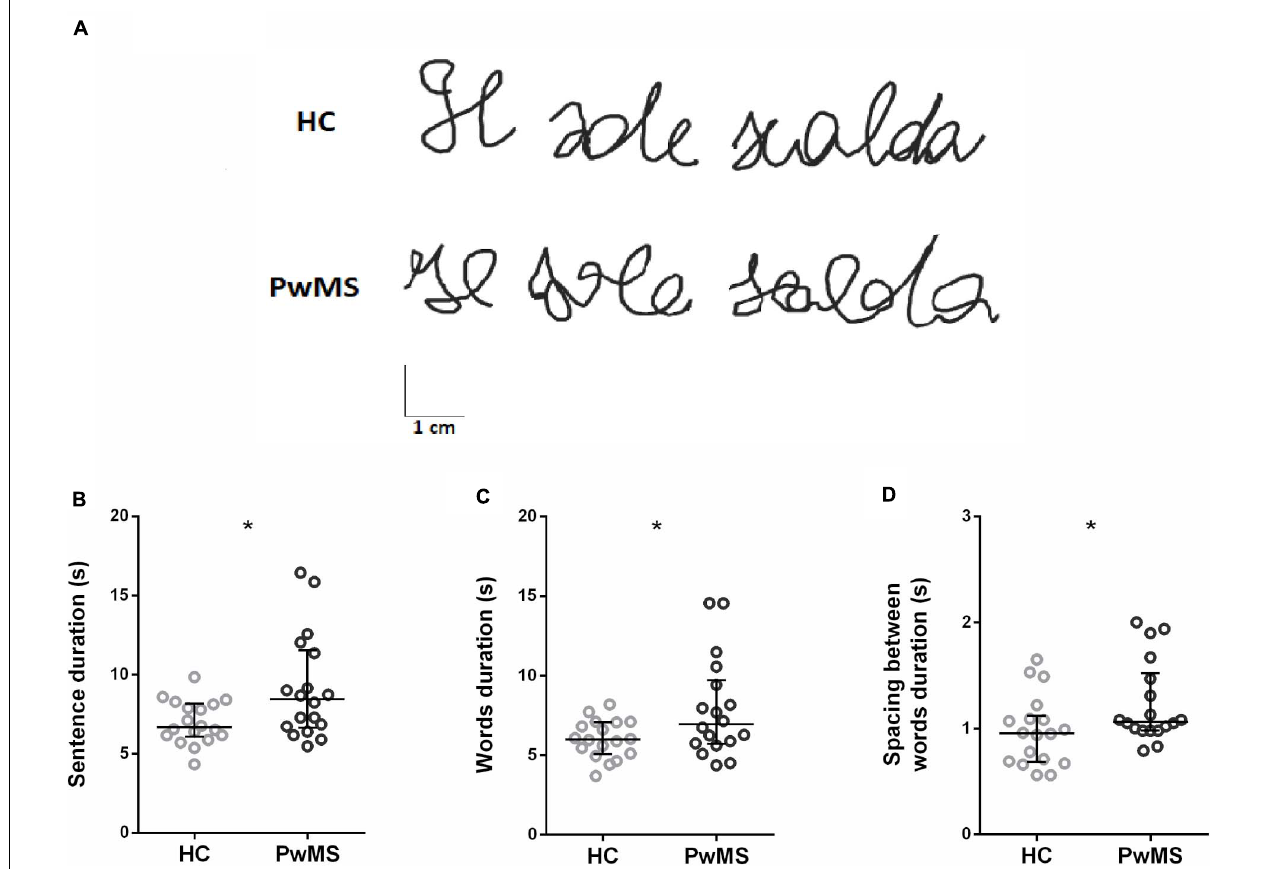
FIGURE 1 | (A) Examples of written traces by two representative participants, one for healthy control (HC) group and one for people with multiple sclerosis (PwMS) group. (B–D) Kinematic parameters describing the handwriting task found to be significantly different between HC (gray) and PwMS (black): (B) duration of the sentence, (C) duration of the words, and (D) duration of the spacing between words. Each circle represents the average value for a single subject. The horizontal line indicates the group median value, and the error bars show the interquartile interval * p < 0.05.